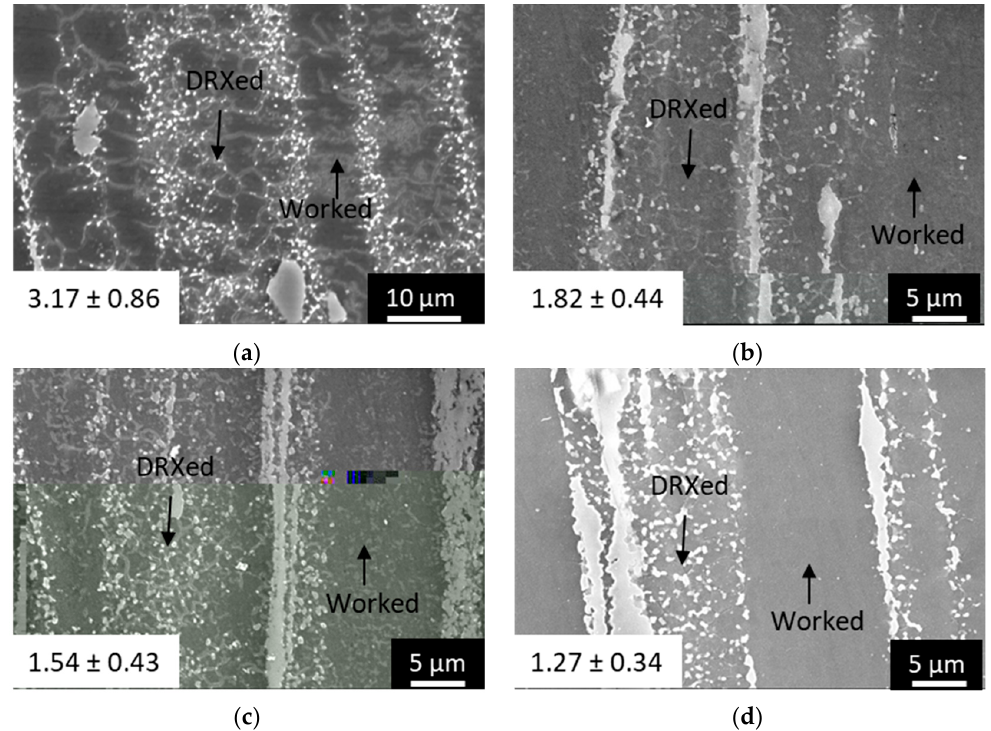
Figure 3. Microstructure of ( a ) AZ91_AR; ( b ) AZ91_0.5DOC; ( c ) AZ91_1DOC; and ( d ) AZ91_1.5DOC alloys with insets of average DRXed values.